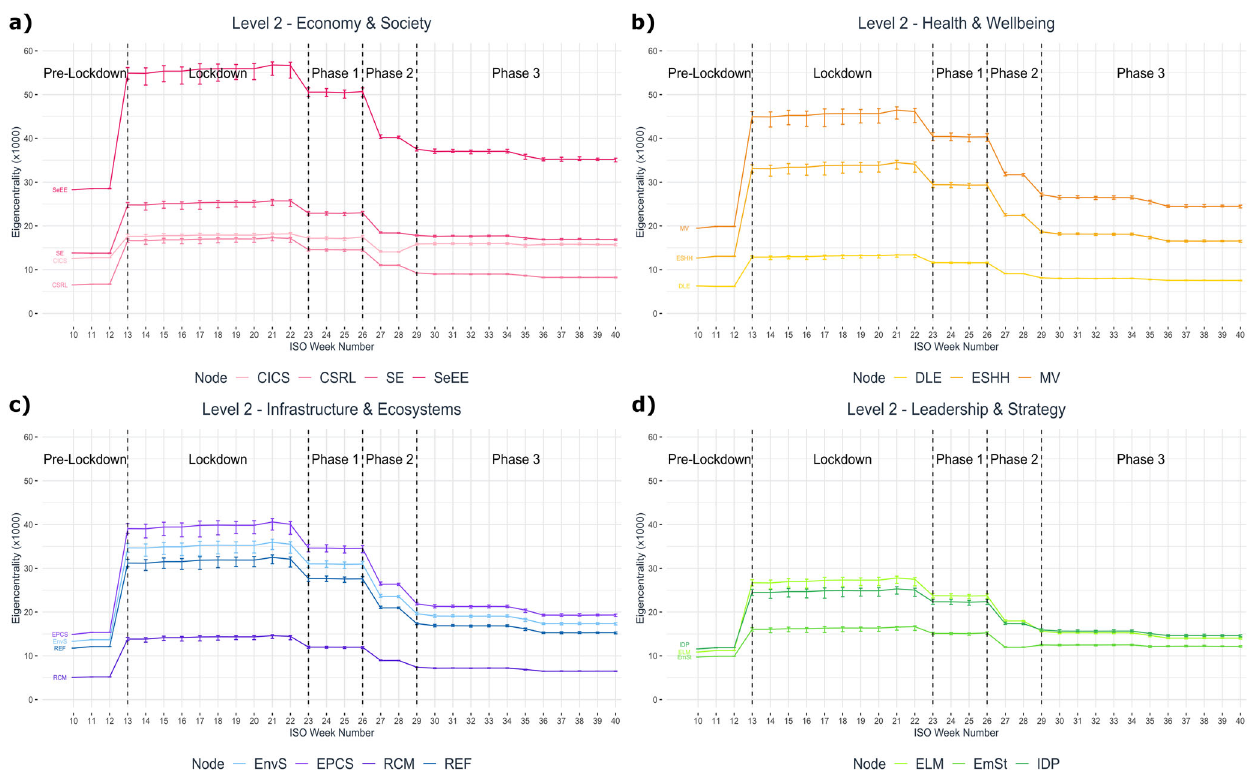
Fig. 4 Time series of eigenvector centrality (EC) values for nodes (EC con fi dence included – see “ Methods ” section) at the outcomes level, throughout the modelled period. Time series in the a economy & society category, b health & wellbeing category, c infrastructure & ecosystems category, d leadership & strategy category (for full node names behind abbreviations see Fig. 5 or Table